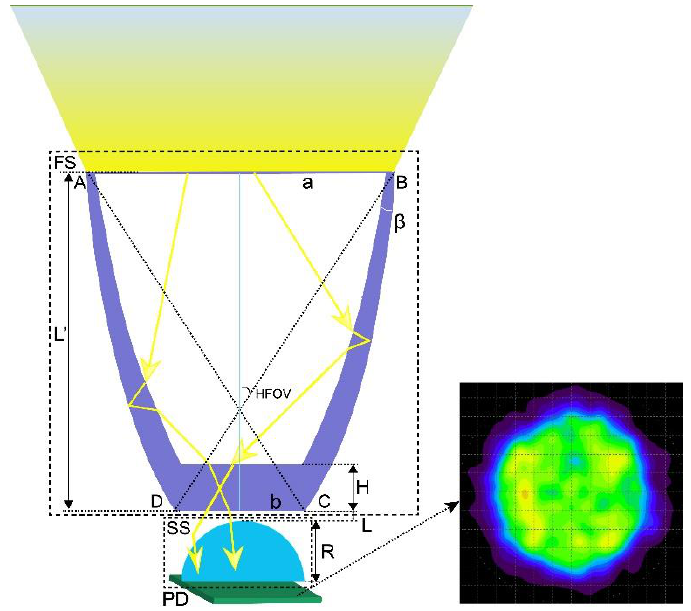
Figure 1. Schematic diagram of the proposed composite optical receiver. FS: first stage of the receiver; SS: second stage of the receiver; AB: incident plane; DC: exit facet of the FS; a: inlet radius; b: outlet radius; β : rotation degree of the FS; H: bottom wall’s height of the FS; L: spacing distance between the FS and SS; R: hemispherical radius of the SS.